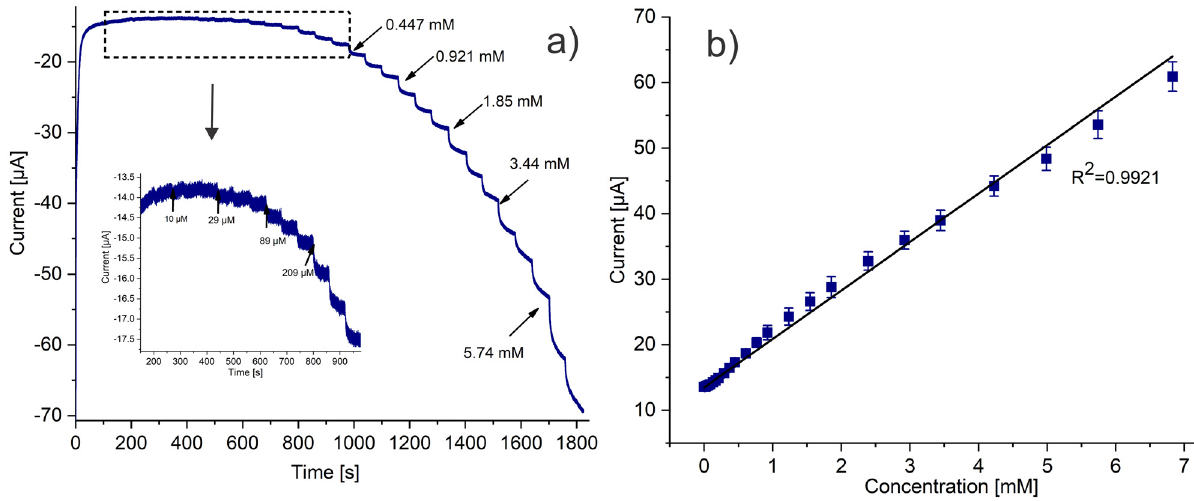
Figure 6: ( a ) Chronoamperometry response for successive H 2 O 2 additions recorder using SPCE/PAni/AuNP/cMWCNT/CAT in PBS 0.01 M at − 0.4 V. ( b ) Calibration